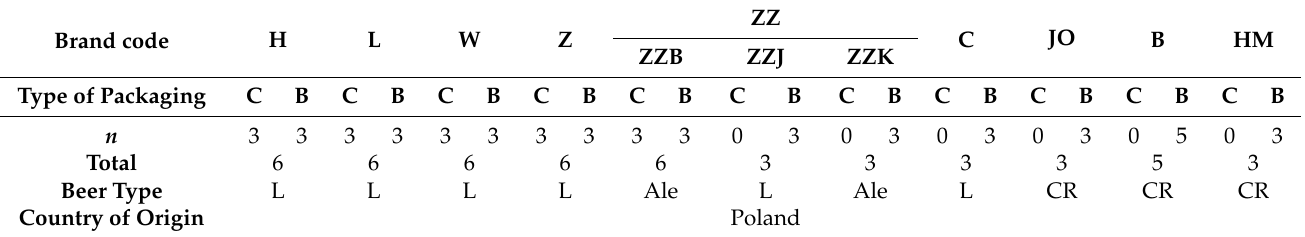
Table 10. Characteristics of the investigated beer